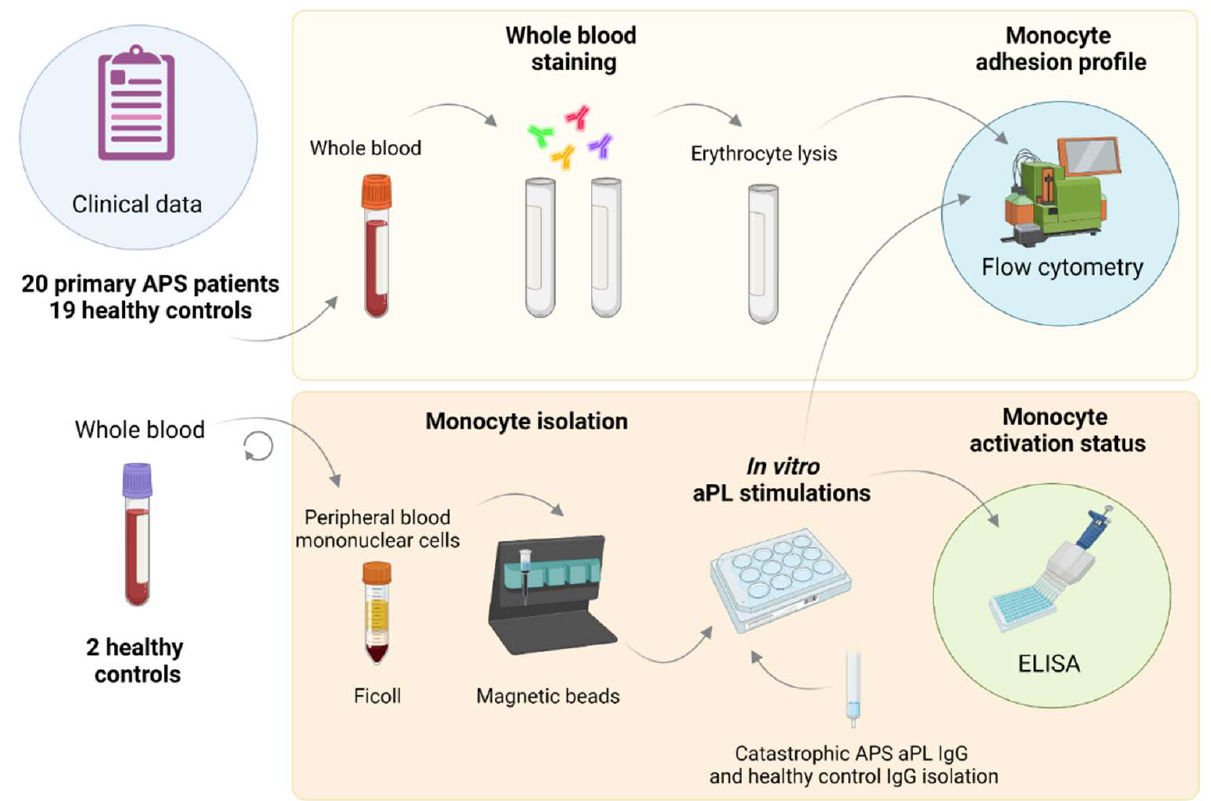
Figure 1. Schematic representation of the study protocol. Clinical and demographic data were collected. Whole blood was drawn and used to perform whole blood fluorescent staining (top panel) and in vitro CAPS aPL stimulations of isolated monocytes (bottom panel). Surface expression of adhesion molecules on both monocytes from APS patients and in vitro stimulated monocytes was determined by flow cytometry. In vitro monocyte activation was measured by ELISA. This figure was created using Biorender.com (accessed on 25 August 2022).